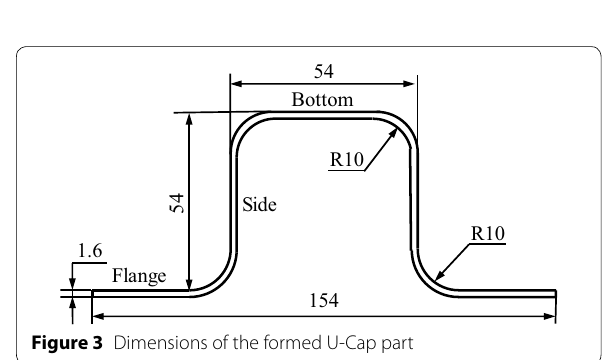
Figure 3 Dimensions of the formed U-Cap part